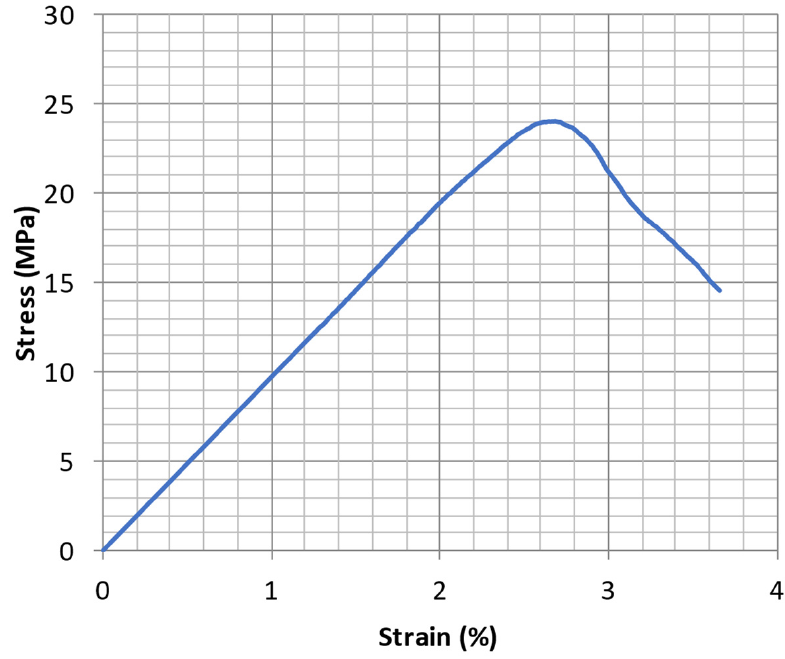
Figure 7. Stress-strain curve of PMMA-steel joint obtained for set 14.